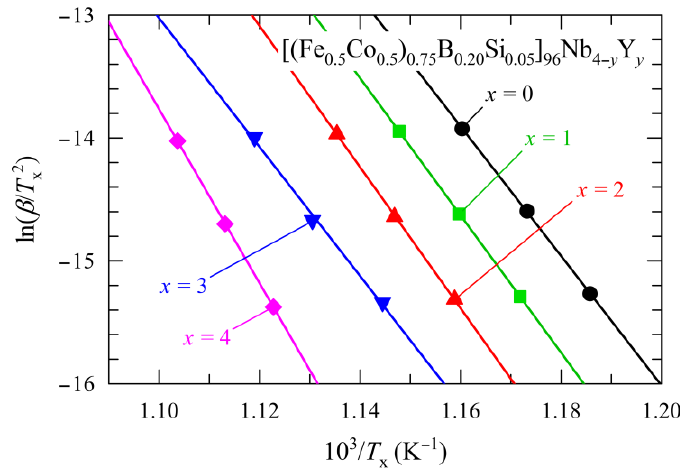
Figure 4. ln(β/ T x 2 ) vs. 1/ T x plot for [(Fe 0.5 Co 0.5 ) 0.75 B 0.20 Si 0.05 ] 96 Nb 4− x Y x alloys. Table 1. Kinetics parameters for onset crystallization temperatures for [(Fe 0.5 Co 0.5 ) 0.75 B 0.20 Si 0.05 ] 96 Nb 4− x Y x alloys.